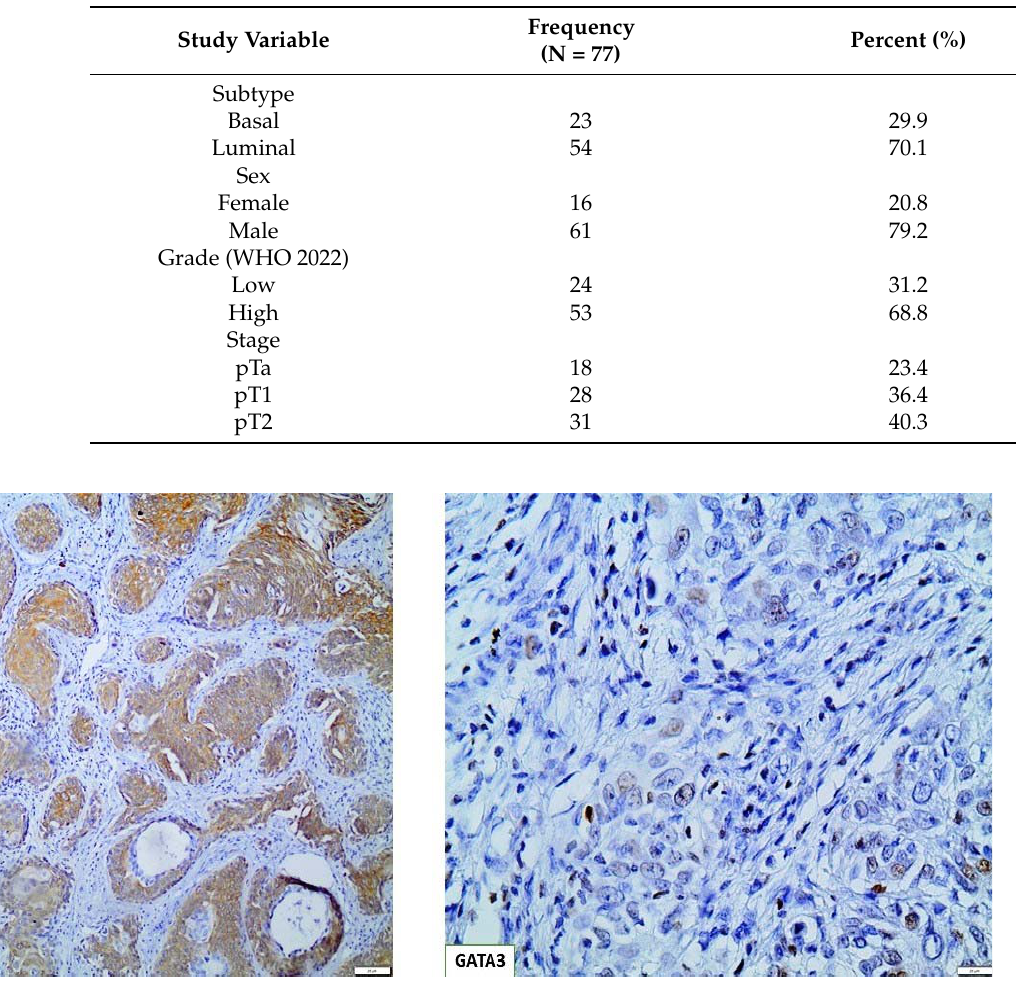
Table 1. Clinicopathological features of obtained bladder cancer samples.